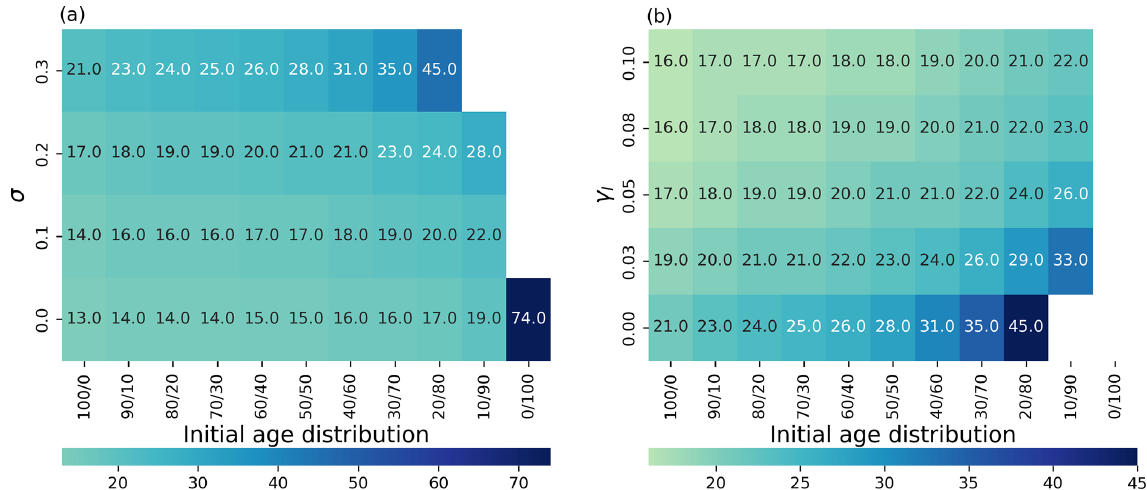
Figure 4. (a) Time to achieve 90% of the maximum carrying capacity as a heatmap (color represents the time in days) depending on the initial age distribution ( x axis; (% of young/old thalli)) and the degradation parameter σ i ( y axis). (b) Time to 90% as a heatmap (color represents the time in days; note the different scales in a and b ) depending on the initial age distribution ( x axis) and the addition of the external inhibitor γ ( y axis). White color means that the population never achieves 90% of the maximum carrying